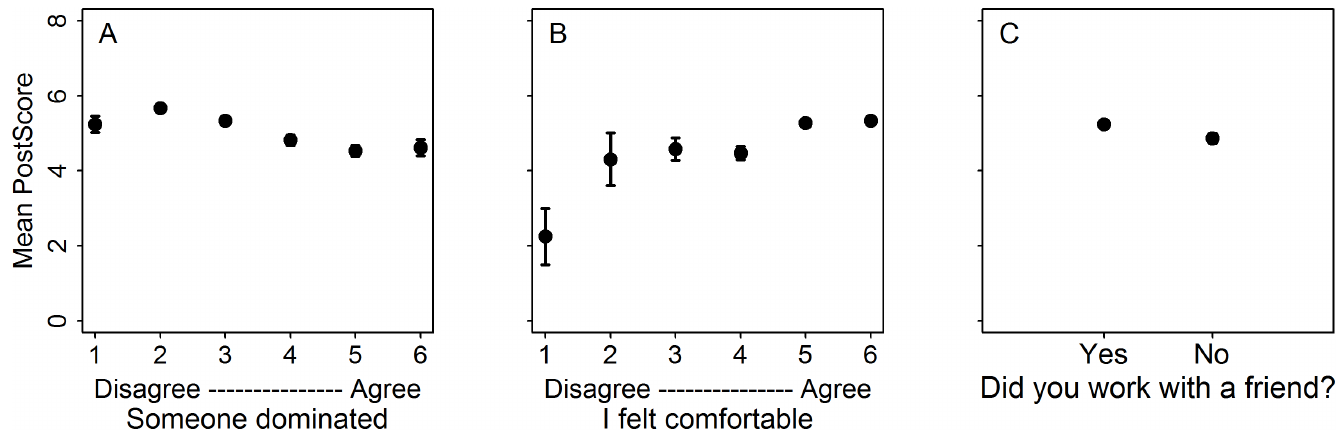
Fig 1. Raw means showing student performance on the post-test as a function of reporting a dominator, being comfortable in their group, and working with a friend. A) Controlling for pre-score, students who strongly agree there was a dominatorin their group performed worse on the post-score than students who reportedlow levels of a dominator; B) Controllingfor pre-score, students who report beingcomfortablein their groups score higheron the post-test; C) There is no effect of friend on performance (note that there is a difference in post-score, not controllingfor pre-score whereinstudents who work with a friend score higheron the post-test (t = -2.6, p < 0.05);this difference is noticeable in this figure). Error bars indicate standarderror. Students answeredthe dominator and comfort questionson a 6-point Likert scale, from Strongly Disagree(1) to Strongly Agree (6). See Table 2 for final models and modeledestimates.